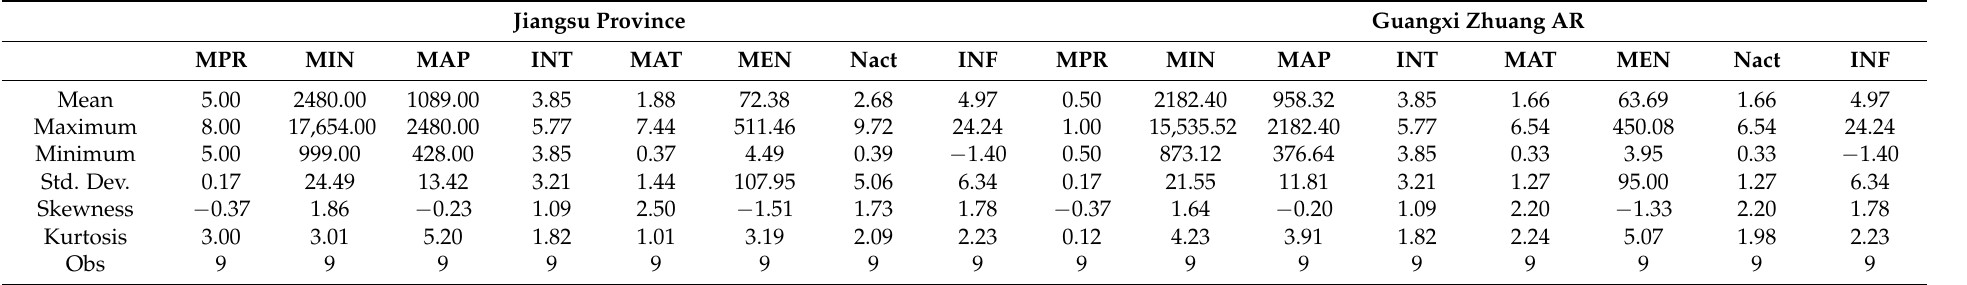
Table 2. Descriptive statistics of